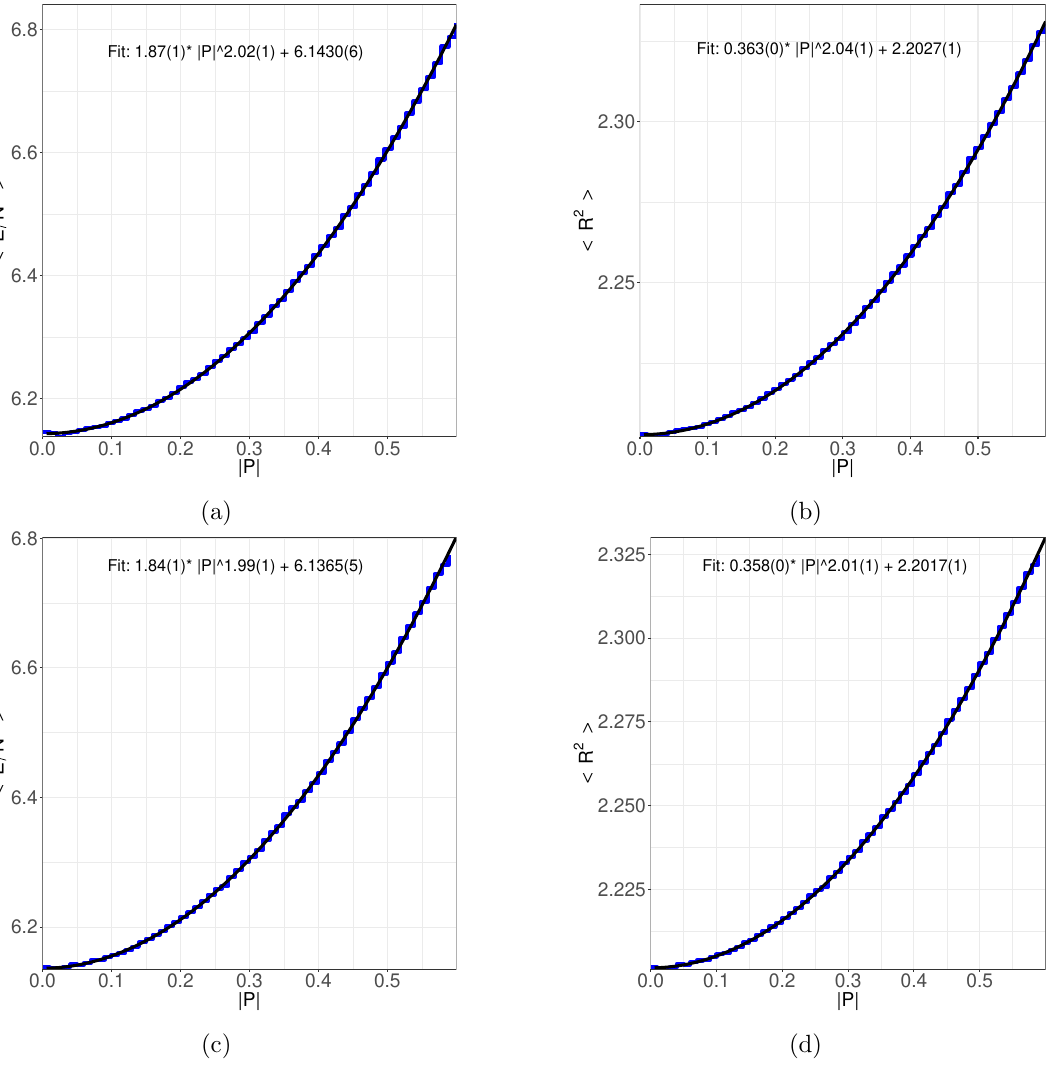
(cid:10) (cid:11) R 2 ( j P j ).